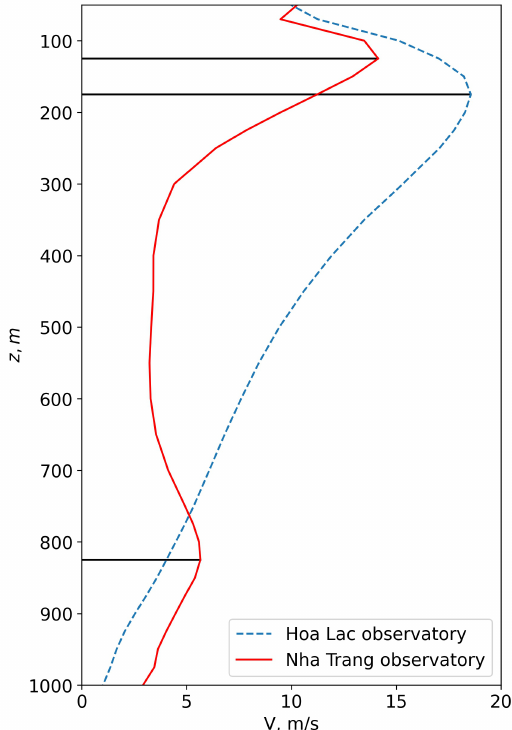
Figure 2. Annual averaged vertical profiles of the wind speed above the astronomical